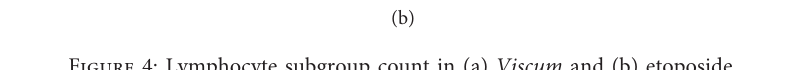
Figure 4: Lymphocyte subgroup count in (a) Viscum and (b) etoposide.